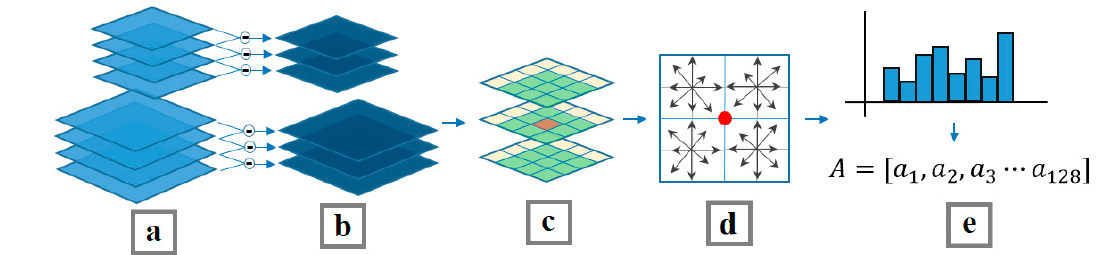
Figure 5. The steps of SIFT feature extraction: ( a ) scale space generation; ( b ) DOG image generation; ( c ) detection of local maximum and minimum; ( d ) gradient calculation; ( e ) histogram calculation and generation of 128 dimensional vectors.